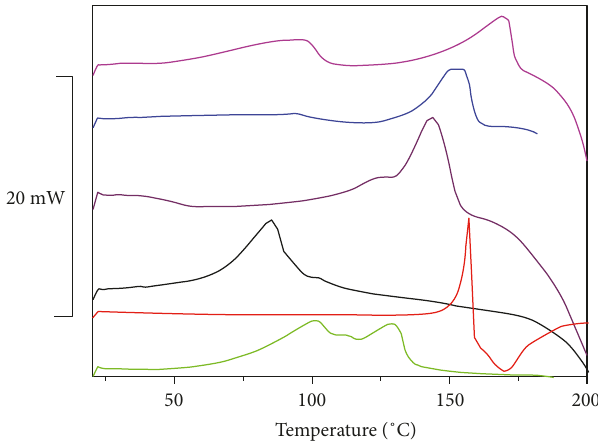
Figure 3: DSC curves of OMP (red) and prepared salts (OMP-K (violet), OMP-Na (blue), OMP-Mg (pink), OMP-Li (green), OMP-Ca (black)). The curves are shifted for clarity.